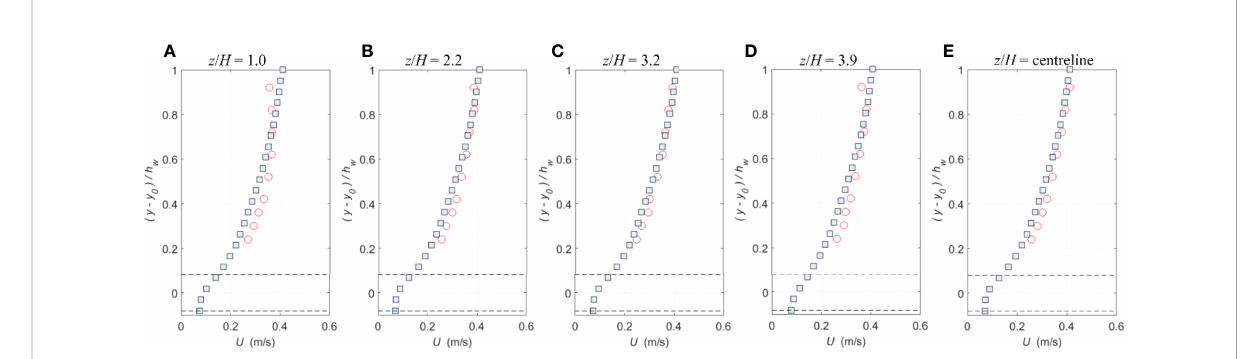
FIGURE 11 (A – E) Comparisons of the lateral pro fi les of time-averaged streamwise velocity between experimental and SPH results for shallow fl ow condition 2 (circles: exp data; squares: SPH; and dash lines: roughness top and